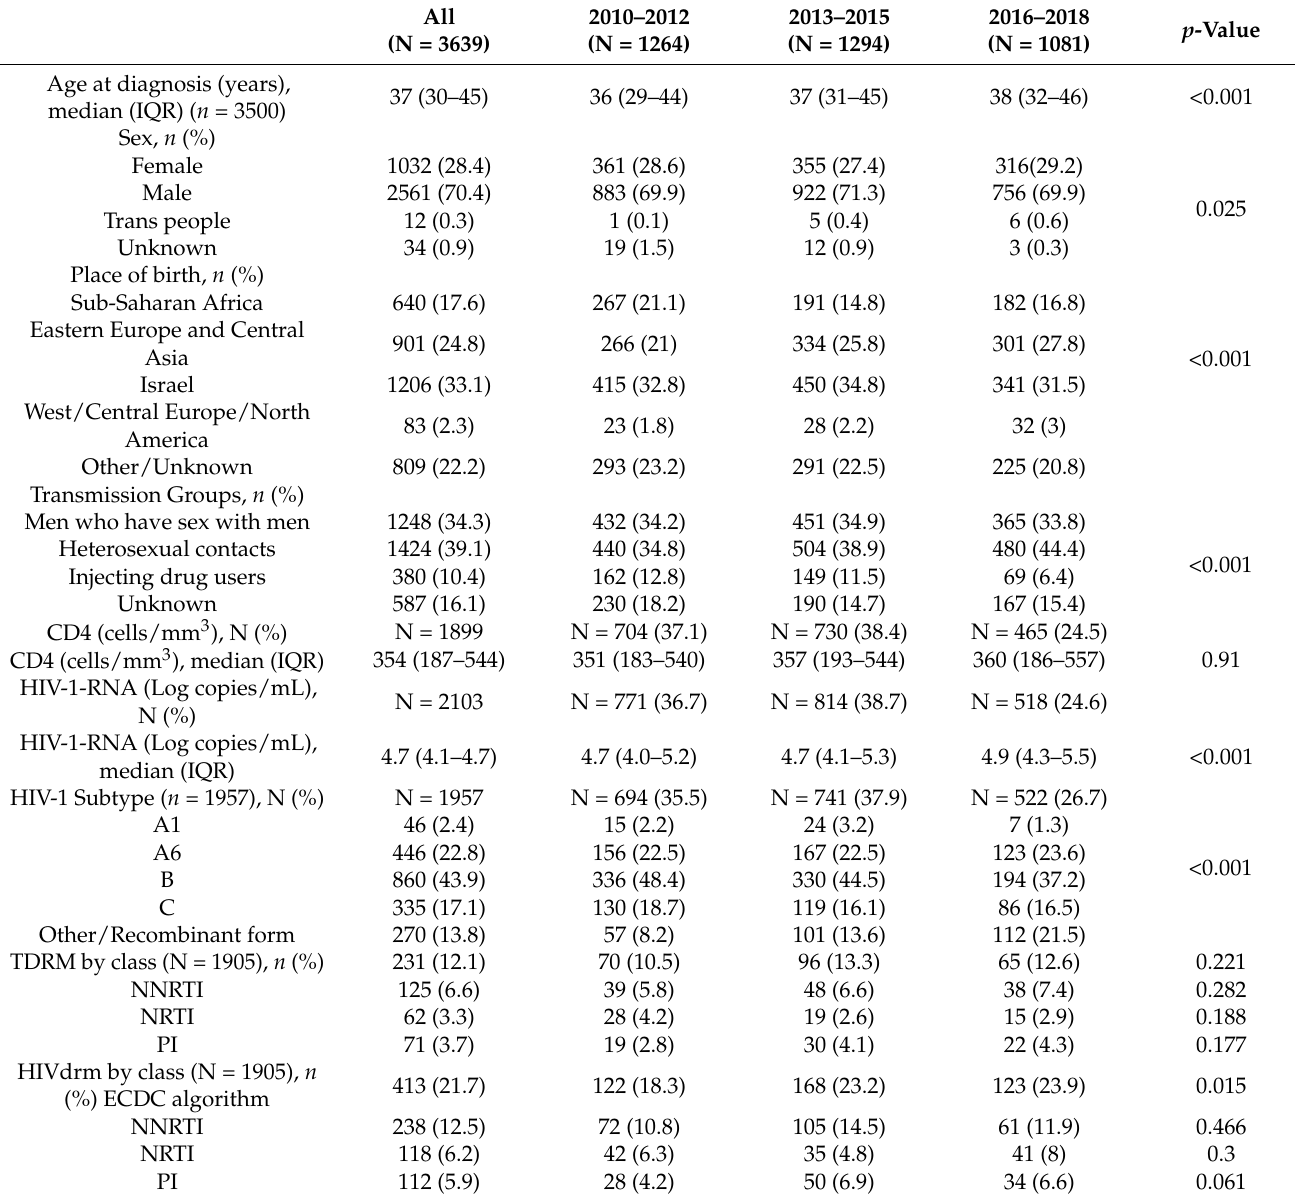
Table 1. Characteristics of newly diagnosed PLHIV, by years of